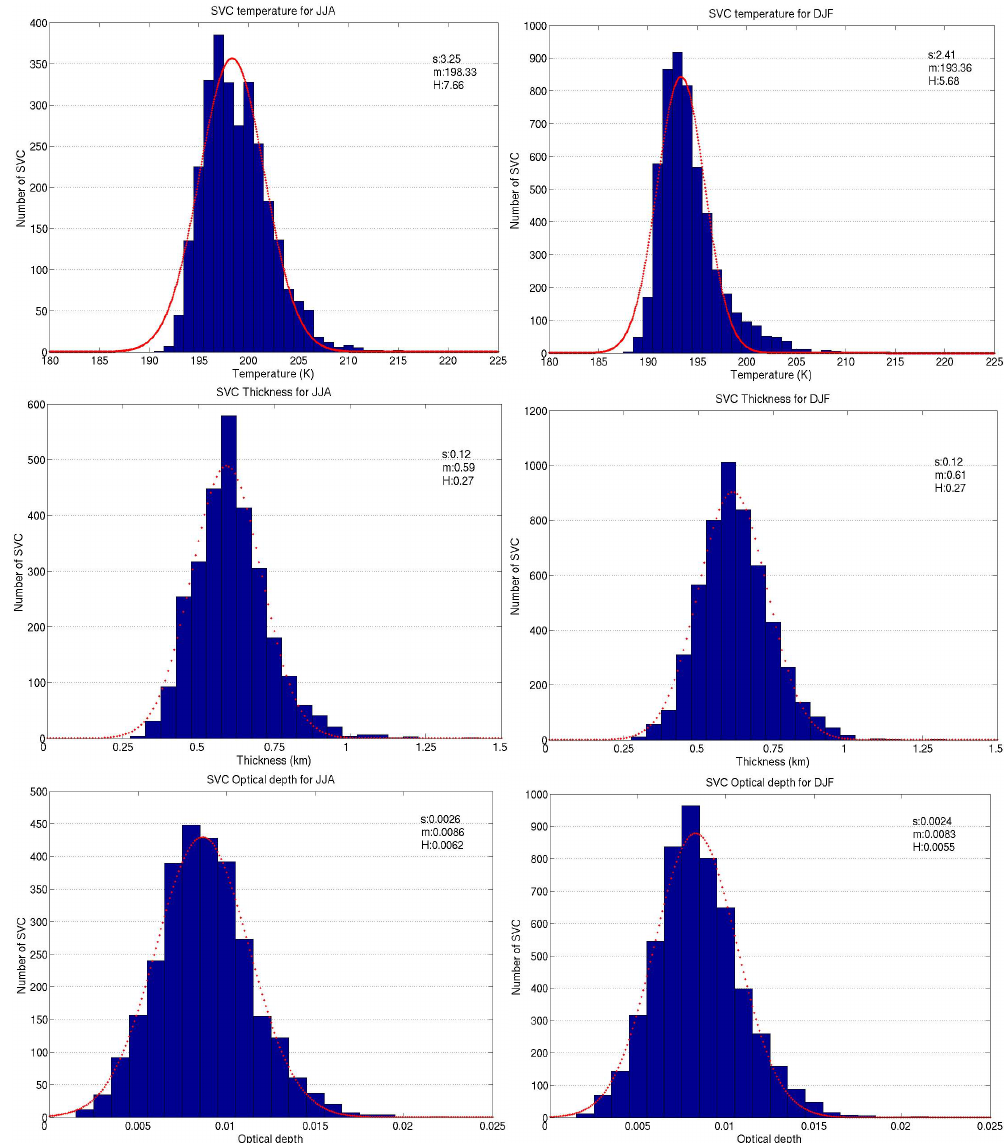
Fig. 2. Histograms of average temperature (row 1), geometrical (row 2) and optical thickness (row 3) for SVC in JJA (left column) and DJF (right), 2006–2008. The mean thickness of SVC is roughly equal to 600m and the mean extension to